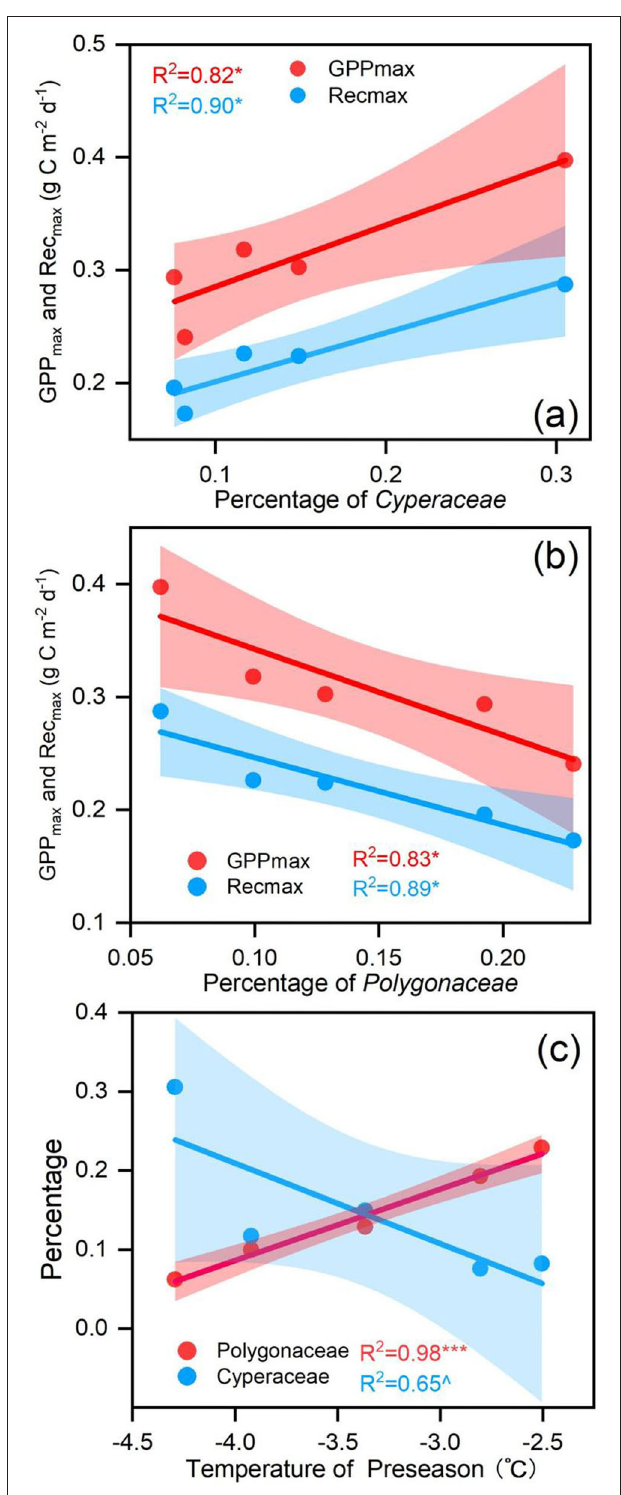
FIGURE 7 | (a) the relationship between the percentage of Polygonaceae and carbon fluxes; (b) the relationship between the percentage of Cyperaceae and carbon fluxes; (c) the relationship between the percentage of Polygonaceae , Cyperaceae and the temperature of the preseason (Tp). ∧ when p < 0.1, * when p < 0.05, ** when p < 0.01, ***when p <